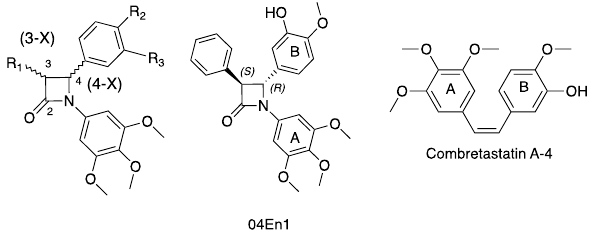
Figure 9. Stereochemistry of β -lactam enantiomers ( left ). 04En1 (3- S , 4 -R ) ( middle ) and CA-4 ( right ).